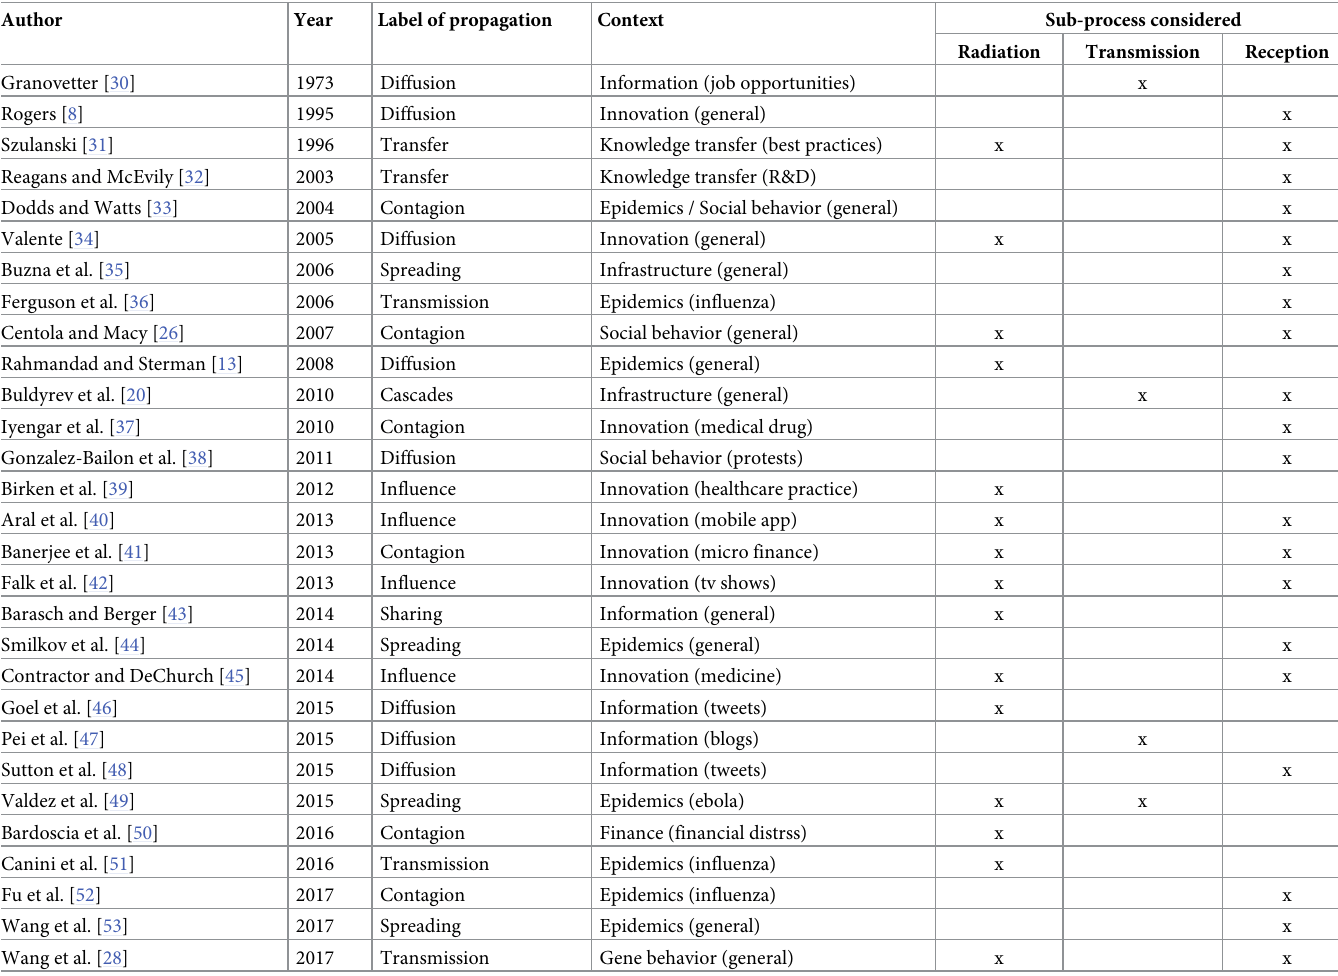
Table 1. This table depicts some examples of the way in which propagation has been operationalized in literature. Different streams of literature focus on different sub-processes, and thus capture only part and not the whole propagation